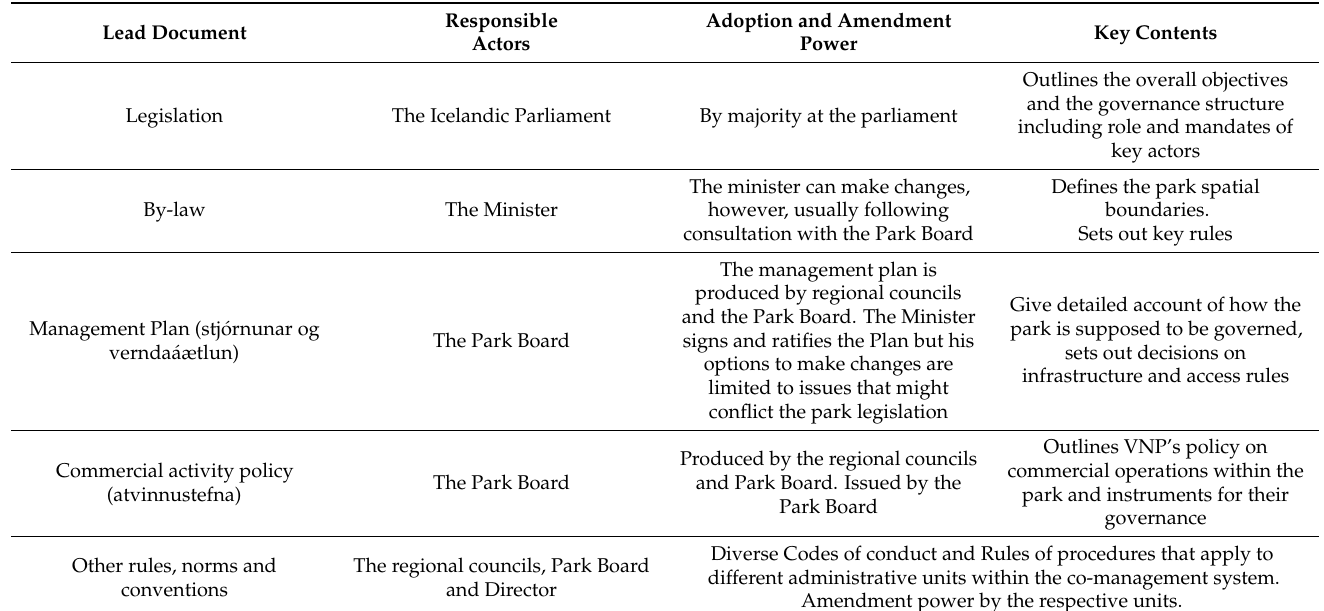
Table 2. Main institutions, defining and guiding VNP